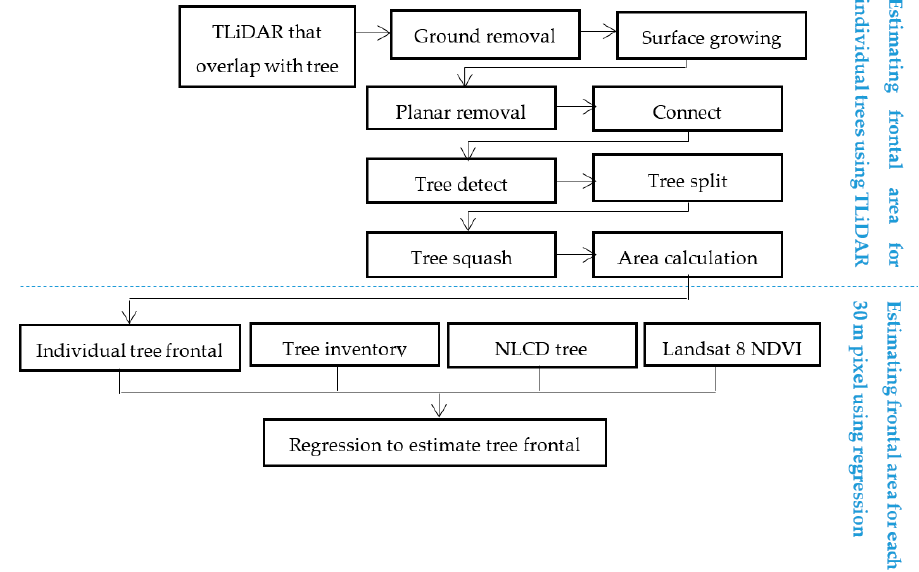
Figure 2. The flowchart of estimating tree frontal areas in urban areas.